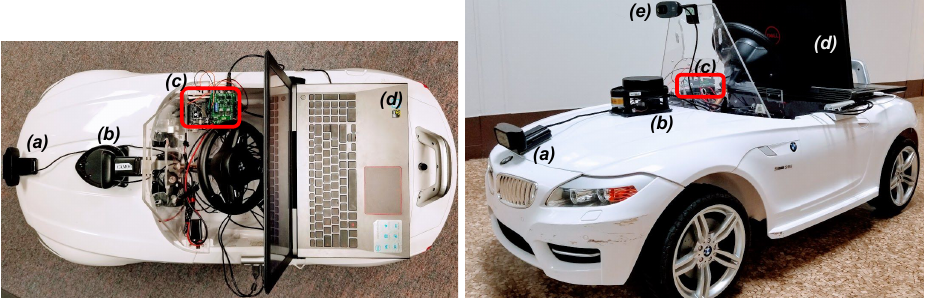
Figure 1. Ridon-Vehicle. Left : The top view of the Ridon Vehicle. Right : The profile view. ( a ) is a camera and ( b ) is a LIDAR for data acquisition. ( c ) is the motor control module. ( d ) is a laptop computer. ( e ) is a camera to take first-person-view videos for the platform.